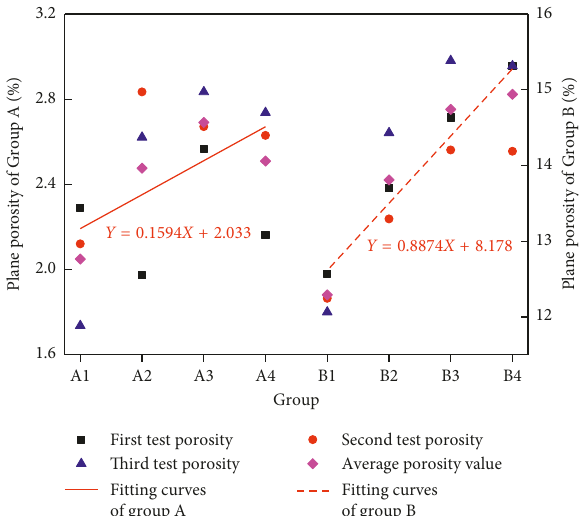
Figure 12: Plane porosity of each group and the fitting curves of the plane porosity of Groups A and B after the curing time of